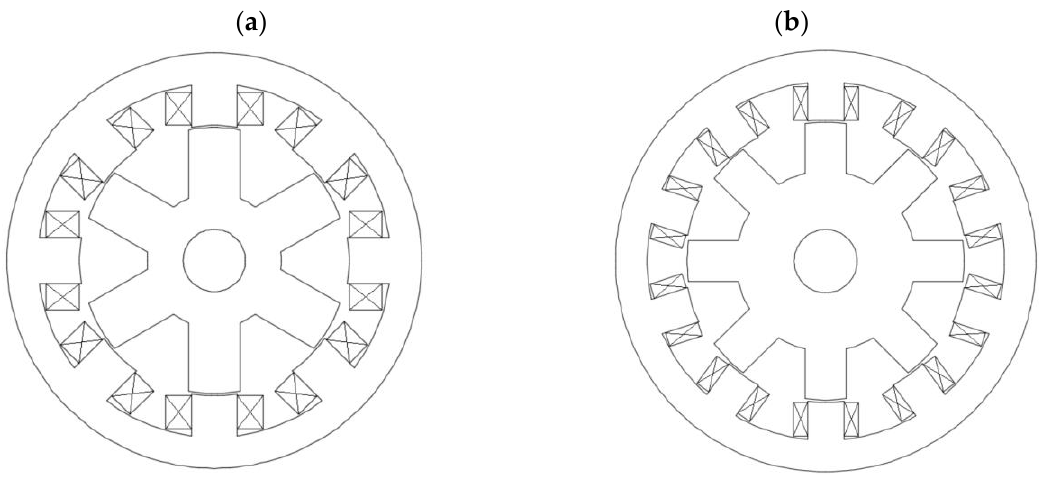
Figure 5. Exemplary cross-sections of different multi-phase reluctance motor types: ( a ) four-phase, 8/6; ( b ) five-phase, 5/8.